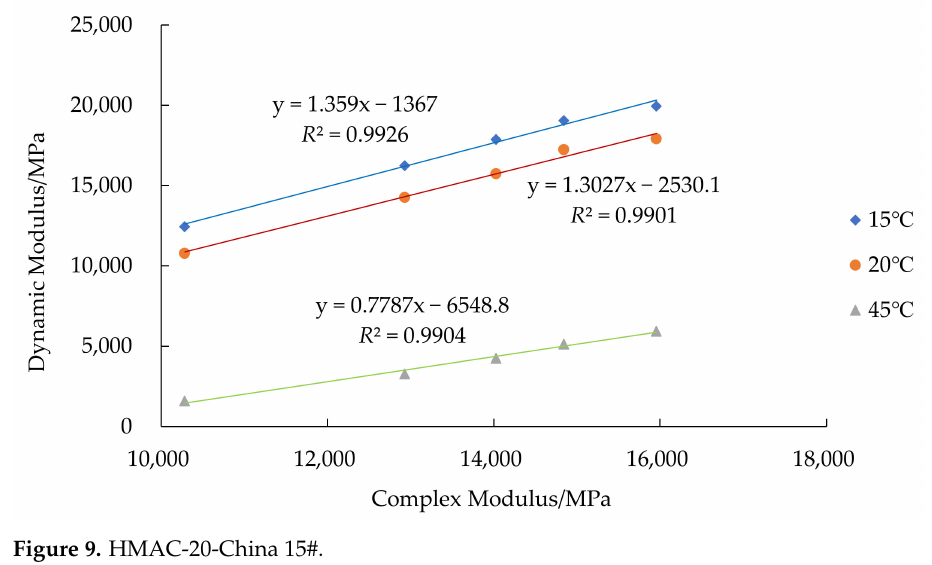
Figure 9. HMAC-20-China 15#.